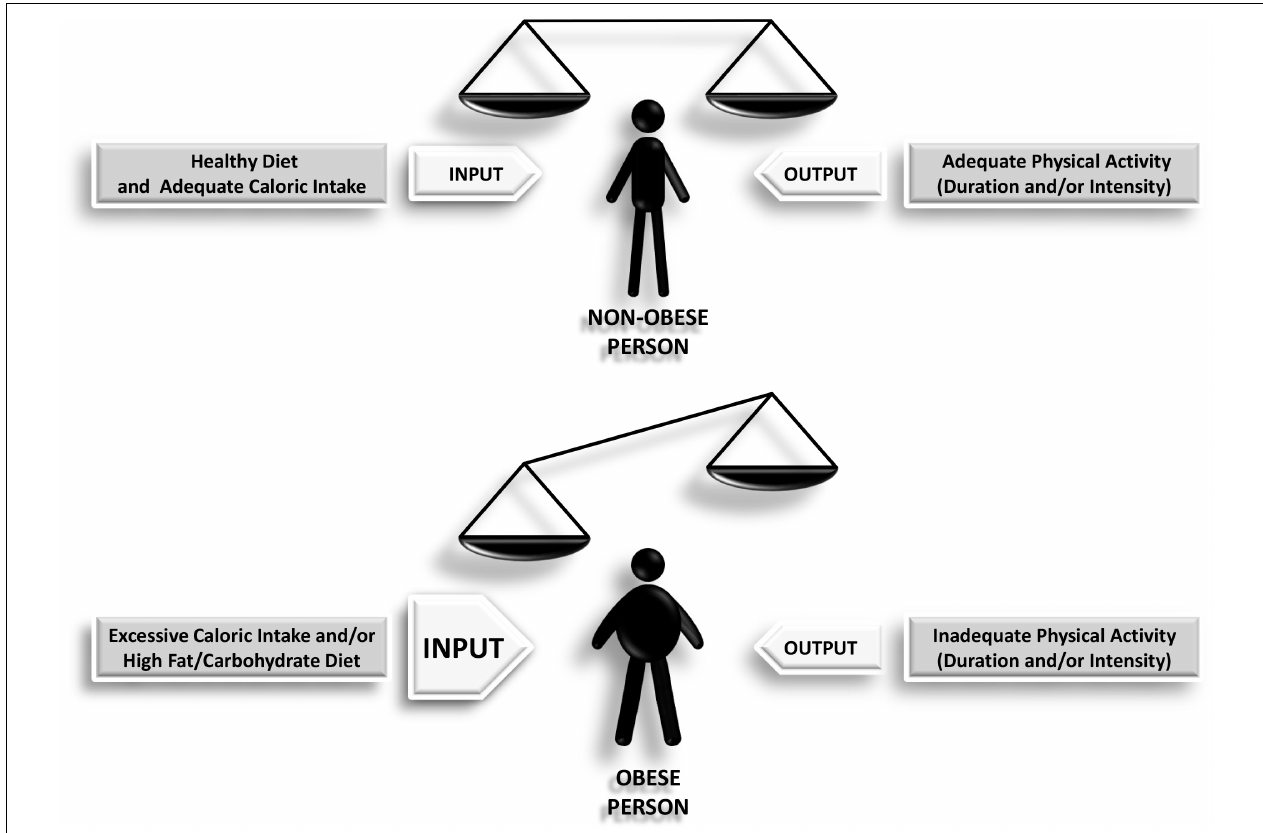
FIGURE 1 | Scheme depicting how the imbalance between the input and the output leads to obesity as a final